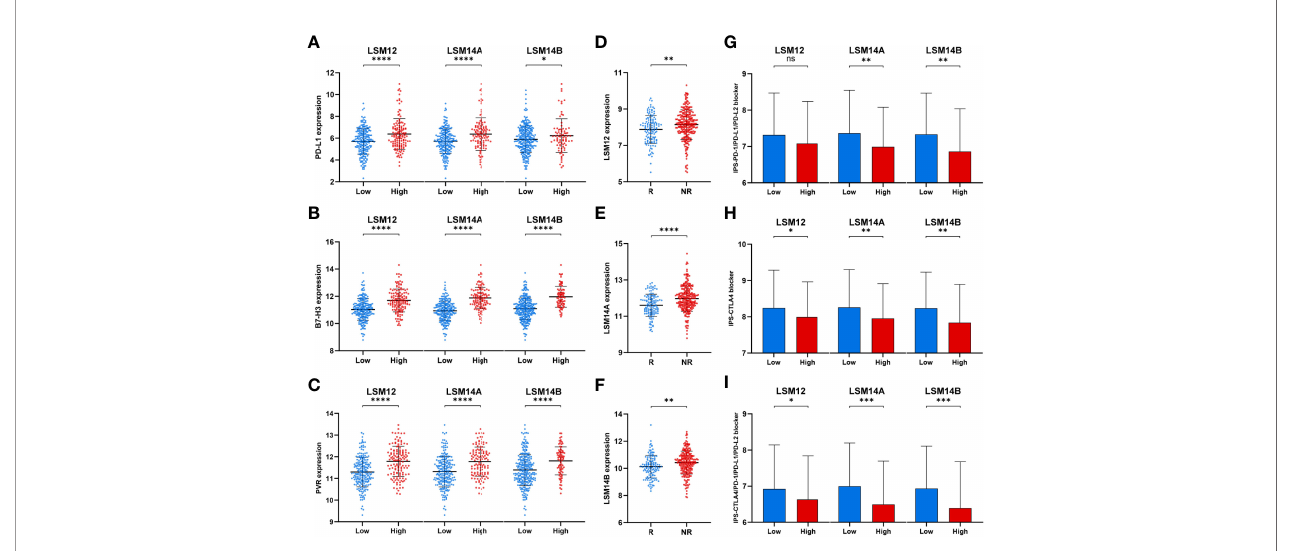
FIGURE 8 | Tumors with higher LSM12, LSM14A, and LSM14B expression exhibited higher expression of tumor-related immune checkpoints and increased therapeutic insensitivity to immune checkpoint blockade. (A – C) Differential expression analysis of tumor-related immune checkpoints (e.g., PD-L1, B7-H3, and PVR) between high- and low-expression groups of LSM12, LSM14A, and LSM14B, respectively. (D – F) Higher expression of LSM12, LSM14A, and LSM14B were observed in ICB-non-response tumors. (G) Tumors with higher LSM14A and LSM14B expression exhibited lower IPS-PD-1/PD-L1/PD-L2. (H) Tumors with higher LSM12, LSM14A, and LSM14B expression exhibited lower IPS-CTLA. ( I ) Tumors with higher LSM12, LSM14A, and LSM14B expression exhibited lower IPS-CTLA4/ PD-1/PD-L1/PD-L2. ICB, immune checkpoint blockade; NR, non-response; R, response. *P-value <0.05; **P-value <0.01; ***P-value <0.001; ****P-value <0.0001.